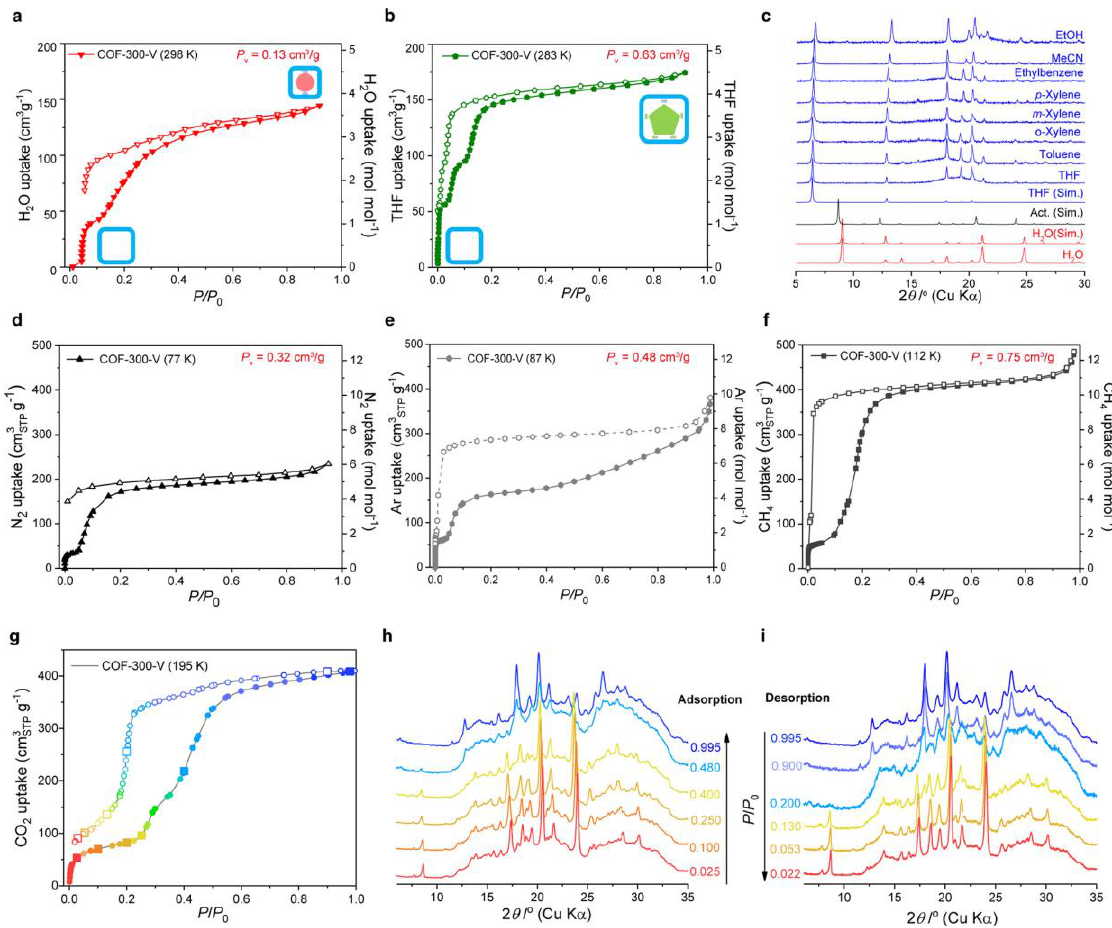
Figure 15. ( a–i ) Guest-dependent dynamics using iconic COF-300 with high crystallinity Reprinted (adapted) with permission from [55]. Copyright {2019} American Chemical Society.